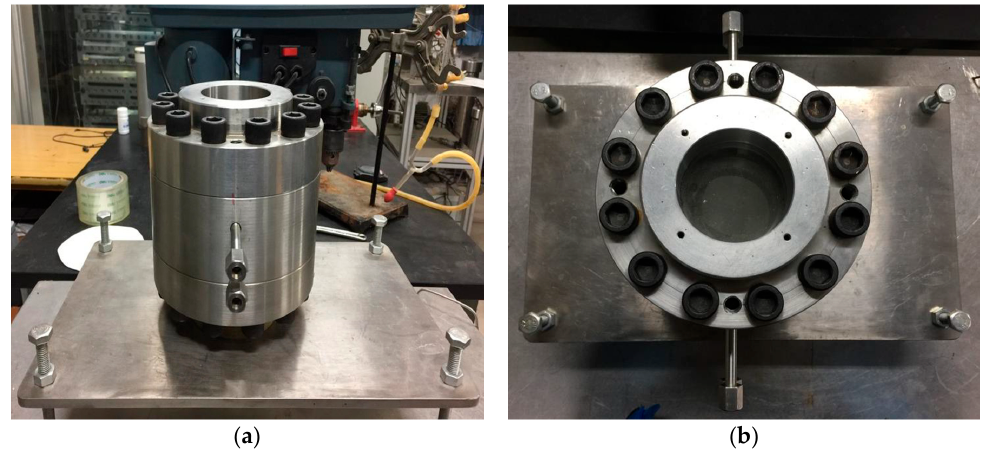
Figure 8. Appearance of the two-dimensional visual micromodel holder: ( a ) Overall structure; ( b ) Top structure.